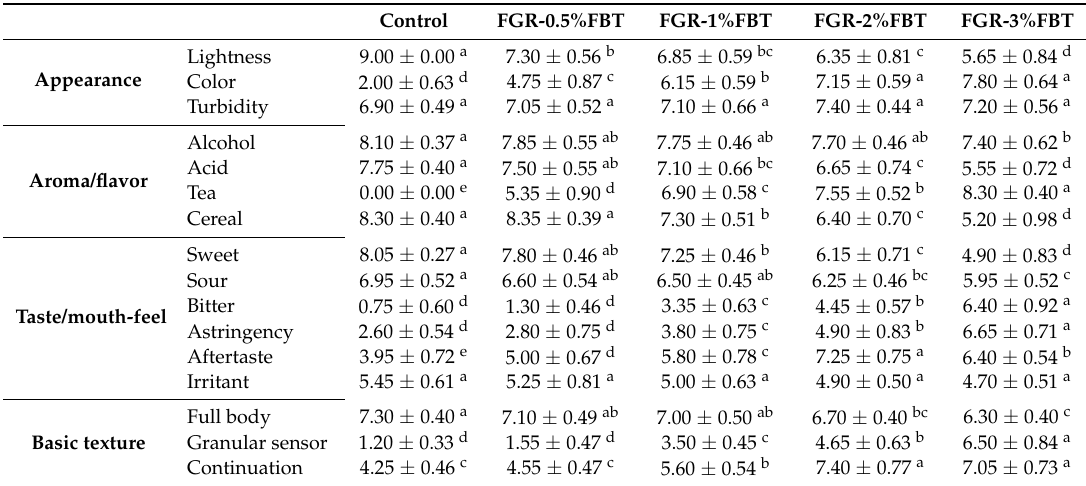
Table 1. Sensory evaluation of fermented glutinous rice with different proportions of the supplementation of Fu brick tea (FGR-FBT) and traditional fermented glutinous rice